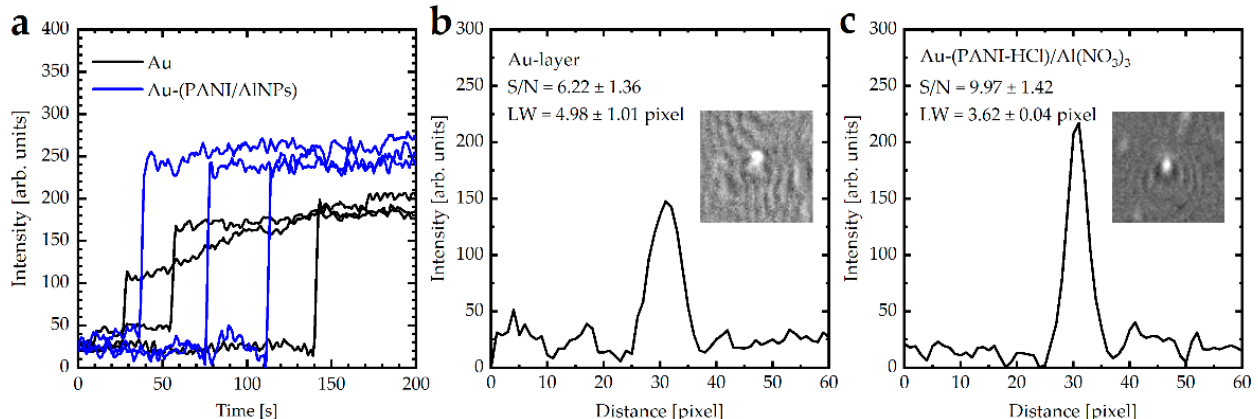
Figure 12. ( a ) Time dependence of the intensity in the middle of the three bright spots for PSNPs by Au-layer and Au-((PANI-HCl)/Al(NO 3 ) 3 ) layers with Al(NO 3 ) 3 concentration of 36 wt.%., ( b ) line profile plot of PSNPs detected by Au-layer, and ( c ) line profile plot of PSNPs detected by Au- ((PANI-HCl)/Al(NO 3 ) 3 ) layers. The inset in ( b ) and ( c ) represents the typical processed image of bound polystyrene particles to the surface, which showed bright spots surrounded by a relatively low-intensity background. Three replicates were performed.